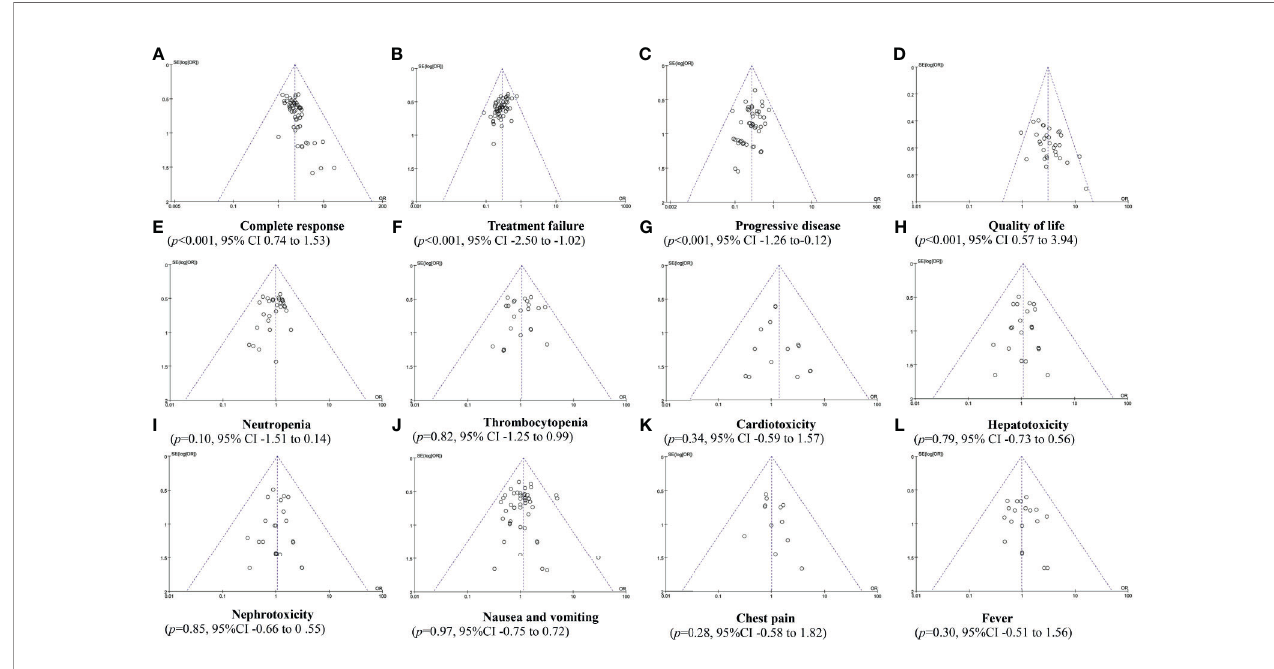
FIGURE 6 | The publication bias